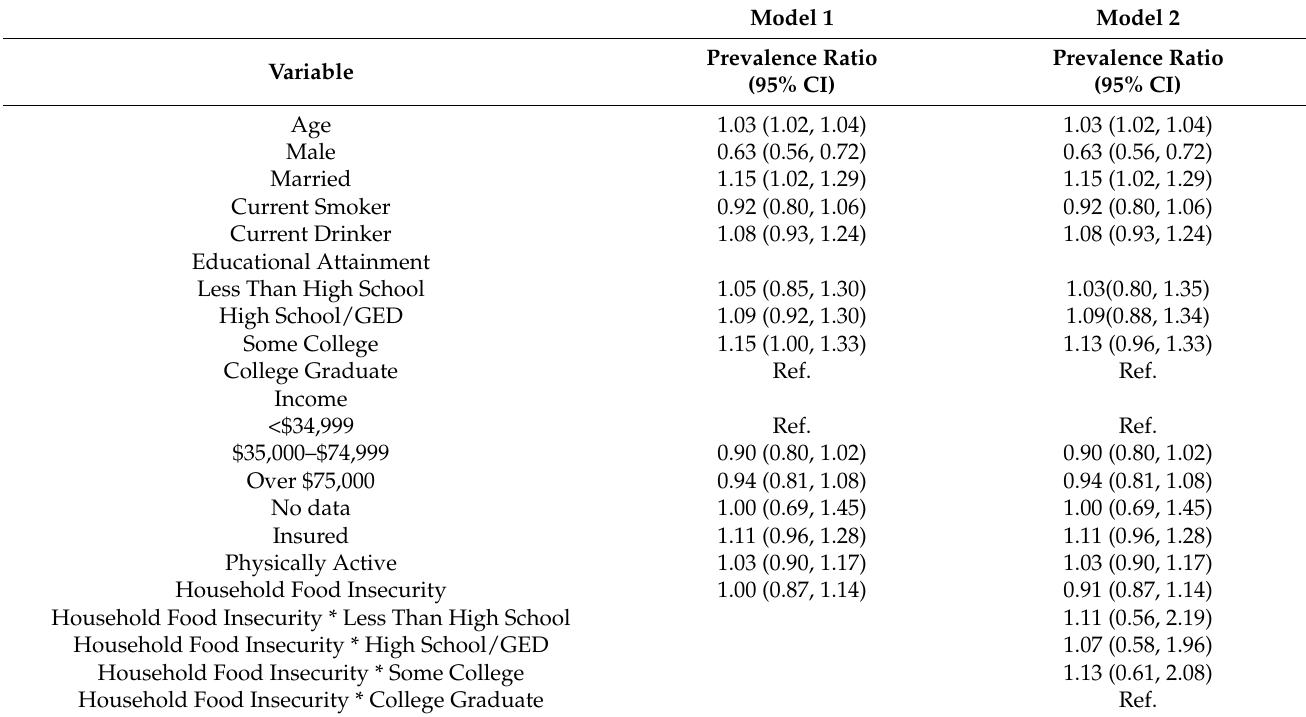
Table 2. Associations of educational attainment and household food insecurity with obesity among 1607 Black young adults (ages 20–39); NHANES